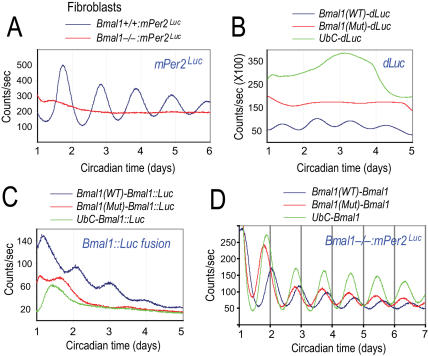
Cyclic expression of BMAL1 is not required for intracellular core clock function.(A) Bioluminescence patterns of fibroblasts derived from WT and Bmal1−/−:mPer2Luc mice. Bmal1−/− fibroblasts are completely arrhythmic, suggesting that Bmal1 is required for clock function in fibroblasts. Circadian time: days after explant medium change. (B) Bioluminescence patterns in wild-type fibroblasts transduced with a lentiviral dLuc reporter. Bmal1(WT): Bmal1 promoter containing WT RORE sequence. Bmal1(Mut): Bmal1 promoter containing mutated RORE sequences. UbC: Ubiquitin C promoter. Unlike the Bmal1(WT), the Bmal1(Mut) and UbC promoters do not confer rhythmic luciferase expression. Circadian time: days after explant medium change. (C) Bioluminescence patterns in wild-type fibroblasts transduced with a lentiviral Bmal1::Luc fusion reporter. Unlike the Bmal1(WT), the Bmal1(Mut) and UbC promoters do not confer rhythmic BMAL1::LUC fusion protein expression. These results suggest that BMAL1 protein does not cycle and that only promoters that contain functional circadian elements confer rhythmic fusion protein expression. Circadian time: days after explant medium change. (D) Representative records of mPer2Luc rhythms in Bmal1−/− fibroblasts restored through genetic complementation. Lentiviral expression vectors carrying Bmal1 cDNA under control of different promoters were introduced into Bmal1−/−:mPer2Luc fibroblasts. The three promoters gave rise to similar levels of BMAL1 protein expression as determined by Q-PCR and Western blotting (data not shown). Both cyclically and constitutively expressed BMAL1 restored circadian rhythmicity in Bmal1−/− fibroblasts, suggesting that the rhythm of BMAL1 protein is not required for basic core clock function. Circadian time: days after explant medium change.